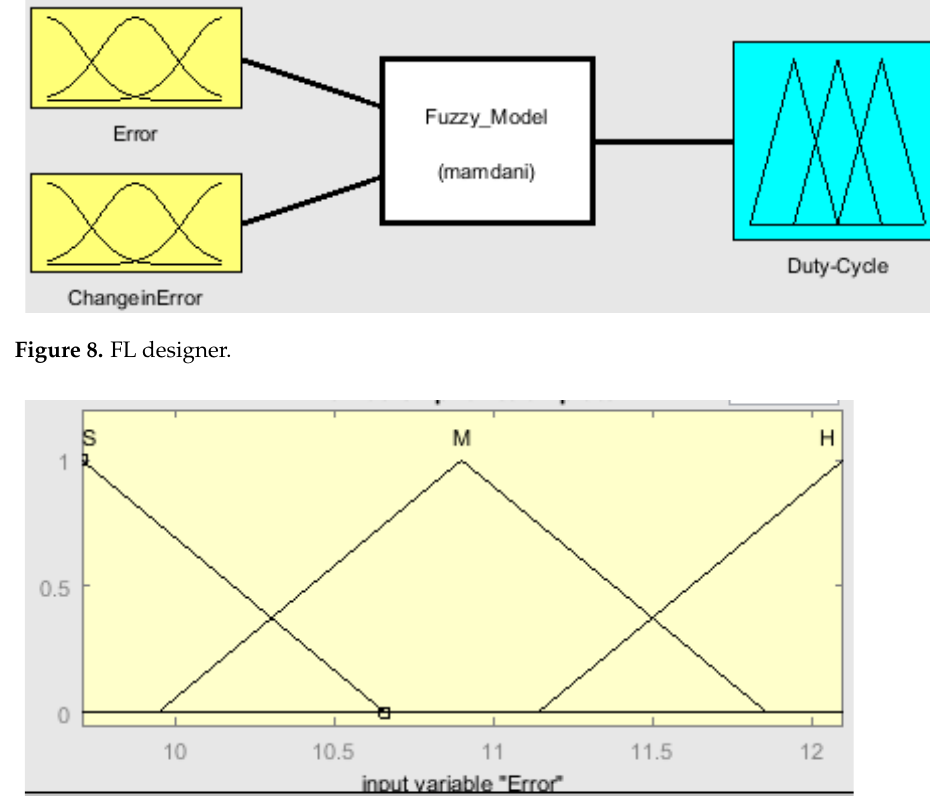
Figure 9. Membership function of input variable in terms of error.